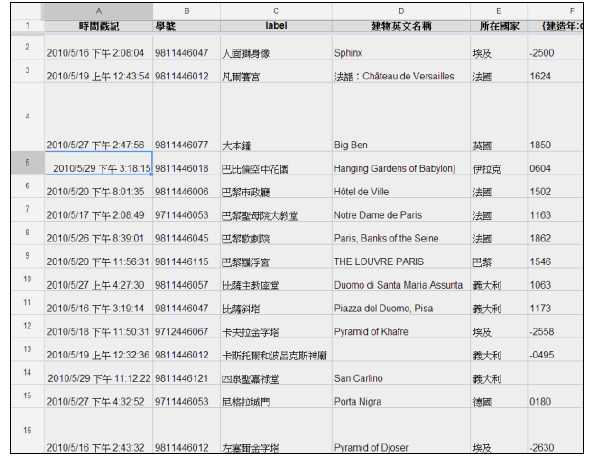
Figure 6. Photo list mode view